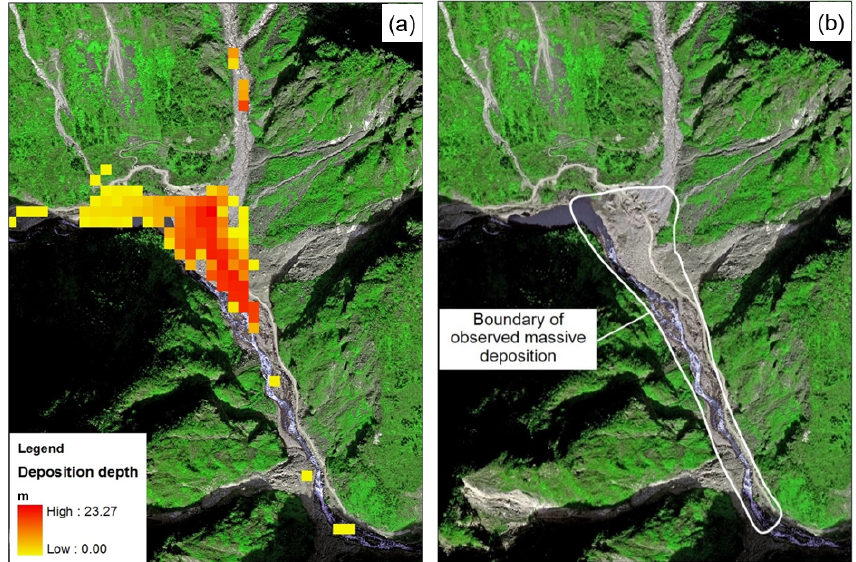
Figure 11. Comparison of the simulated and observed deposition zones: (a) simulation result; (b) enlarged view of the observed deposition area (Chen and Zhang,